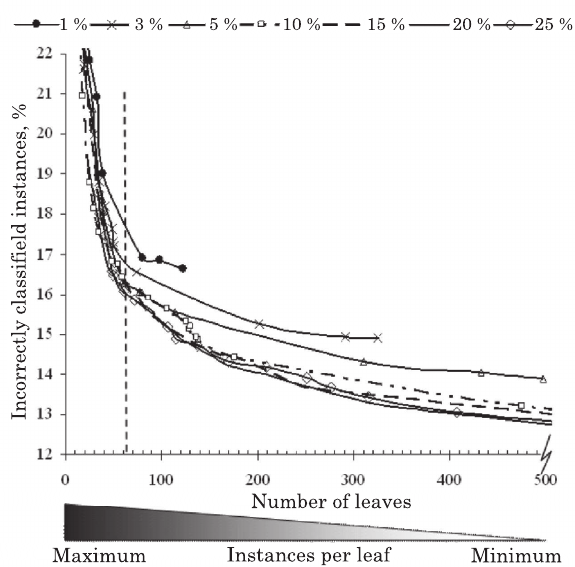
Figure 2. Decision tree generated by the WEKA program. Terminal leaves are associated with one of the seven mapping units. Mapping Unit (MU), elevation (ELEV), vertical distance of the drainage system (DIST) and slope